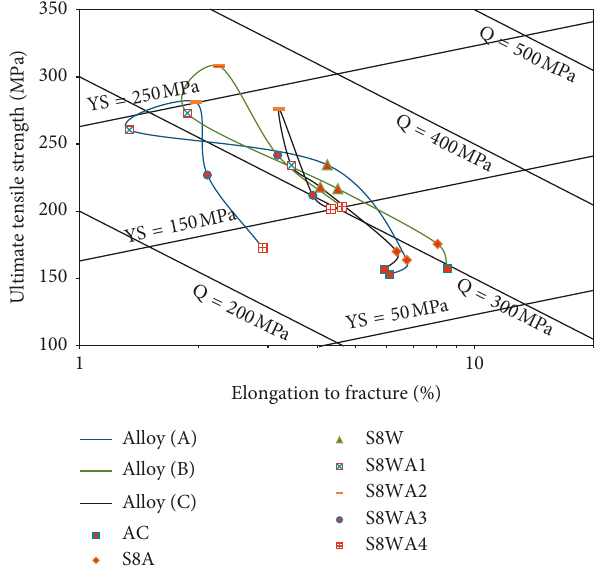
Figure 12: Quality chart showing relationship between UTS and % El for the A B and C alloys in the as-cast and six heat treatment conditions with SHT for 8h.